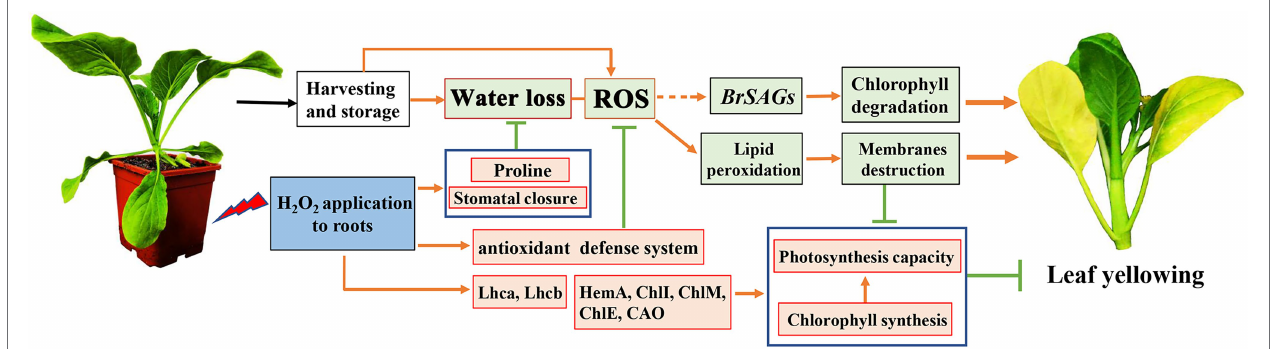
FIGURE 8 | A proposed model of mechanism underlying preharvest H 2 O 2 treatment delayed leaf yellowing of Chinese flowering cabbage during storage by alleviating oxidative stress and water loss. Red boxes indicate upregulation and green boxes indicate downregulation, being modulated by preharvest H 2 O 2